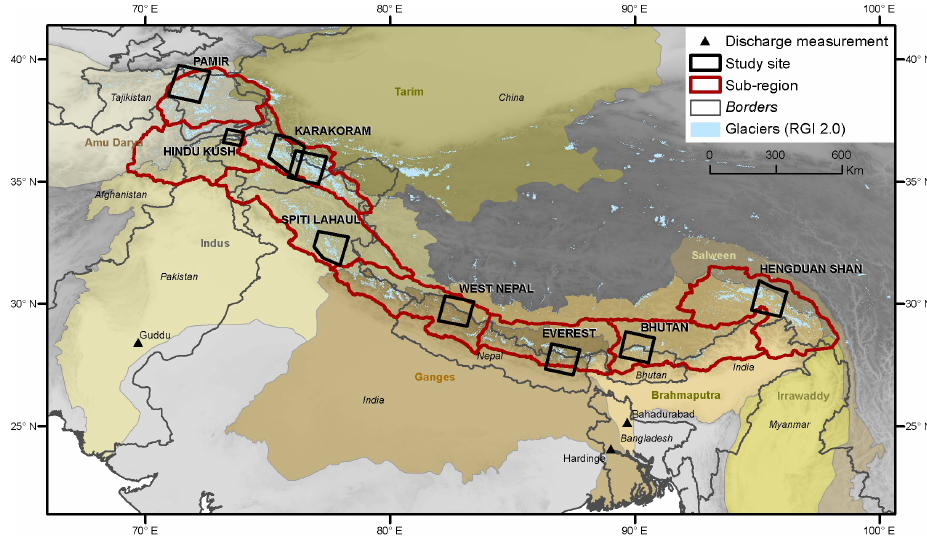
Fig. 1. Overview of the extent and location of the nine study sites (black polygons) and corresponding sub-regions (red polygons) along the PKH range. Brownish-filled background polygons represent the major river basins of the area. Triangles indicate the location of discharge measurements discussed in Sect.